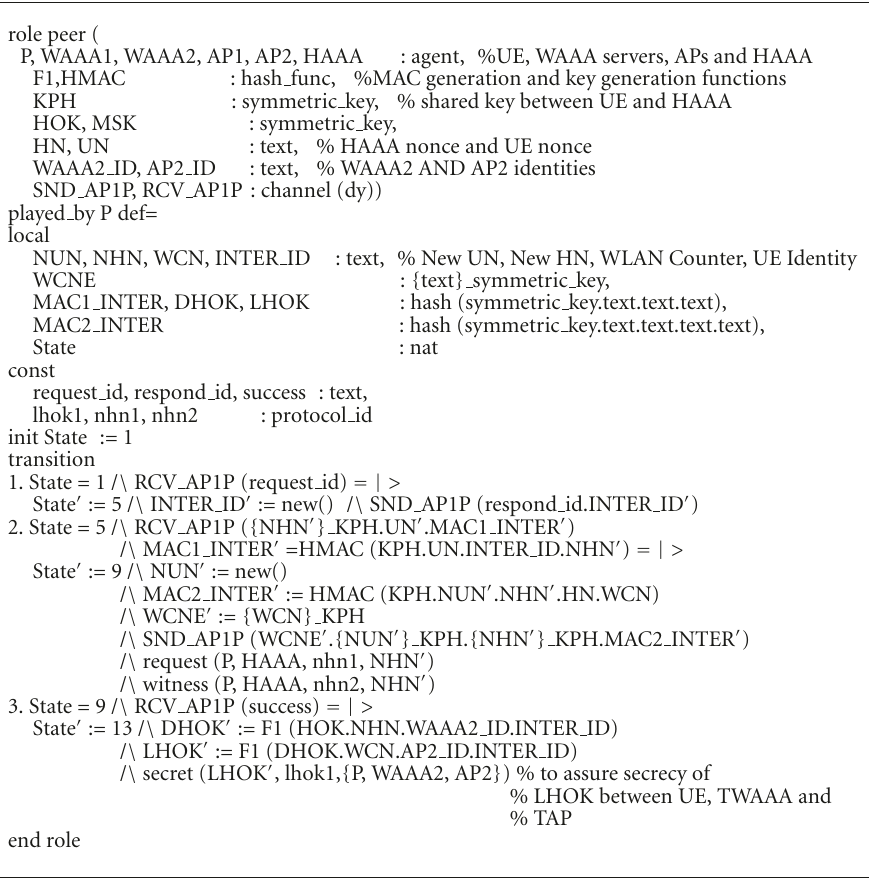
Figure 14: HLPSL code describing UE’s role in Inter-WLAN